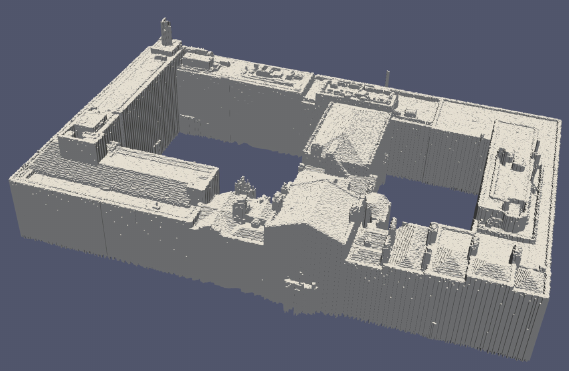
Figure 5. The resulting voxel model of a single